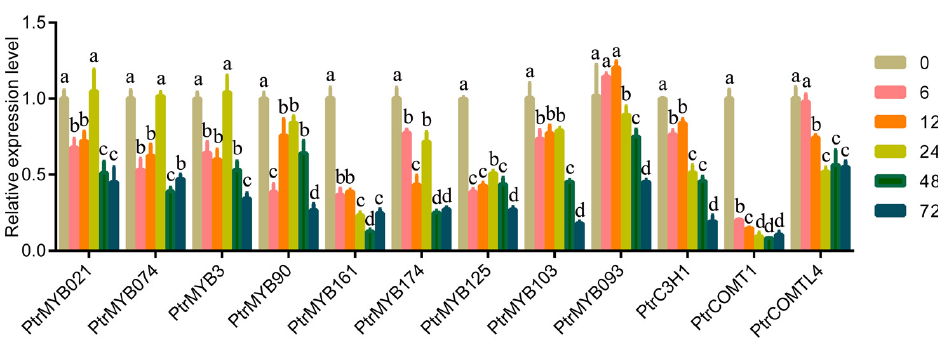
Figure 6. qRT-PCR analysis of genes. RT-qPCR analysis of PtrMYB021 , PtrMYB074 , PtrMYB3 , PtrMYB90 , PtrMYB161 , PtrMYB174 , PtrMYB125 , PtrMYB103 , PtrMYB093 , PtrC3 ′ H1 , PtrCOMT1 , and PtrCOMTL4 of poplar stems with cold treatment for 0, 6, 12, 24, 48 and 72 h. The same letter of P 0.05 level indicates that there is no difference, while different levels of P 0.05 indicate differences. The data are shown as the mean±SE from three replicates. The sample of 0 h was used as the calibrator. DEG, differentially expressed genes; LT, low temperature; RT-qPCR, reverse-transcriptase quantitative real-time PCR.